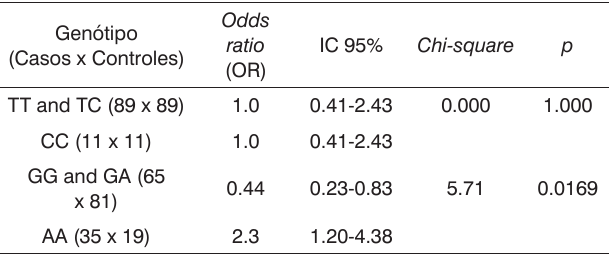
Table 4. Genotype relation between index cases and controls for T102C and -1438G/A polymorphisms of the 5-HTR2A gene. Genótipo (Casos x Controles)